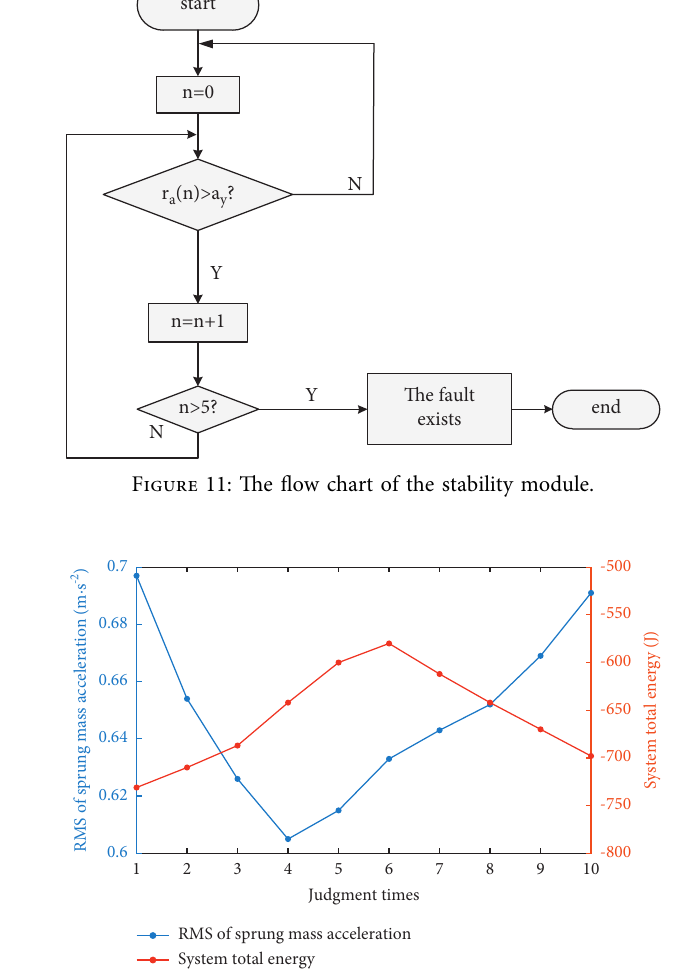
Figure 12: The influence of sampling frequency on the sprung mass acceleration and system total energy. Table 3: Suspension system parameters.